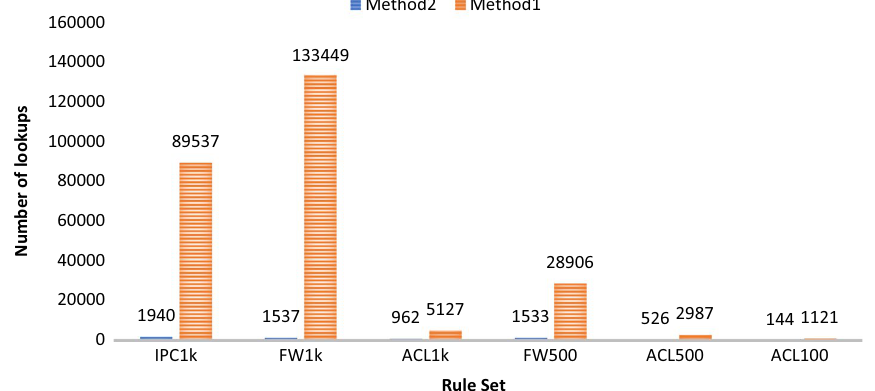
Fig. 10 Number of lookups for adding a